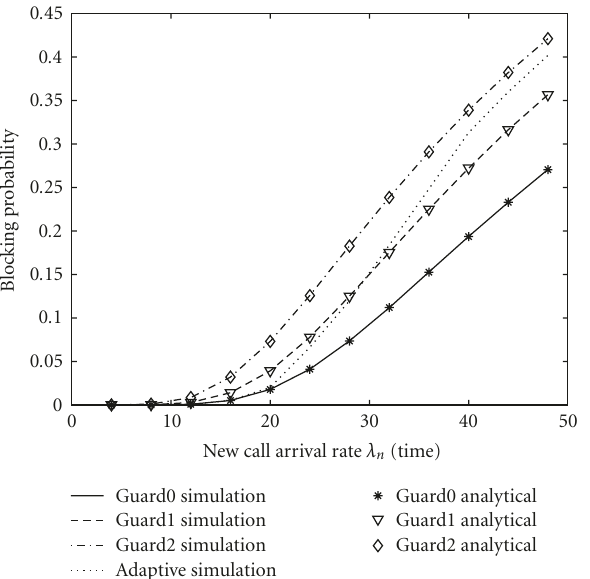
Figure 7: Simulation results of channel utilization for nineteen-cell wrap around